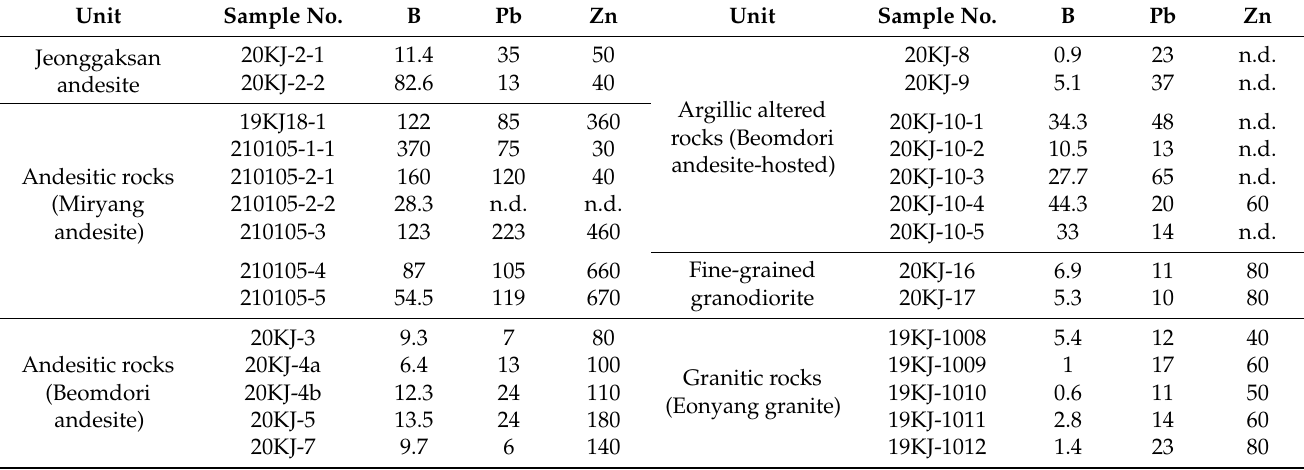
have moderately anomalous boron contents, ranging from 0.9 to 44.3 ppm (Table 1). Both fine-grained granodiorite and Eonyang granite have relatively low boron contents of 5.3 and 6.9 ppm for the fine-grained granodiorite and 0.6 to 5.4 ppm for the Eonyang granite (Table 1). Considering the boron contents, the altered andesitic rocks of the Jeonggaksan Formation and Miryang andesite, as well as the axinite skarn in the deposit, would be affected by boron-bearing fluid. Therefore, a boron-rich fluid probably affected the argillic alteration of the Beomdori andesite as well as the skarn alteration in the deposit. The granitoids such as fine-grained granodiorite and Eonyang granite can be excluded from the boron source due to their low boron concentrations. Table 1. Boron, lead, and zinc contents (ppm) of the altered rocks and neighboring granitoids near the Gukjeon Pb–Zn deposit. Unit Sample No. B Pb Zn